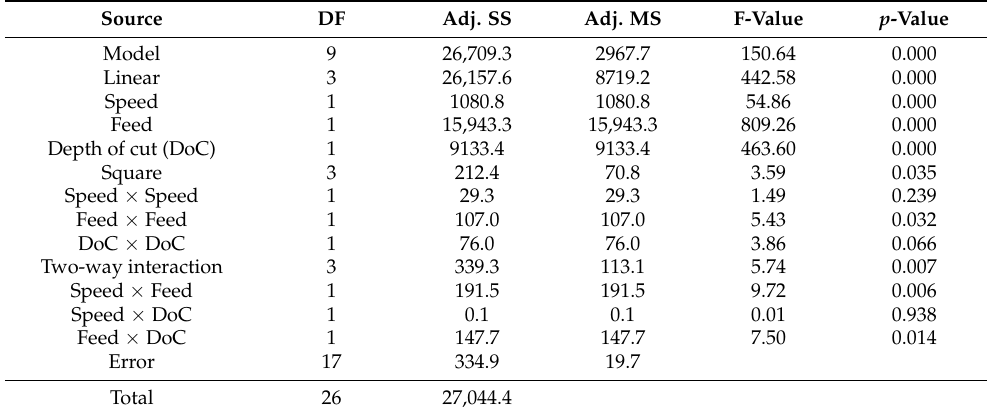
Table 5. ANOVA for the cutting force of the RZ5/8 wt.% TiB 2 composite using adjusted SS for